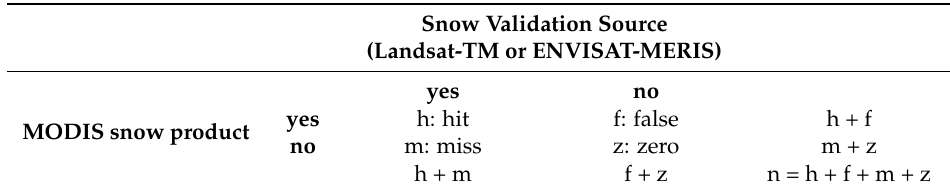
Table 1. Contingency table used to determine hit rate and